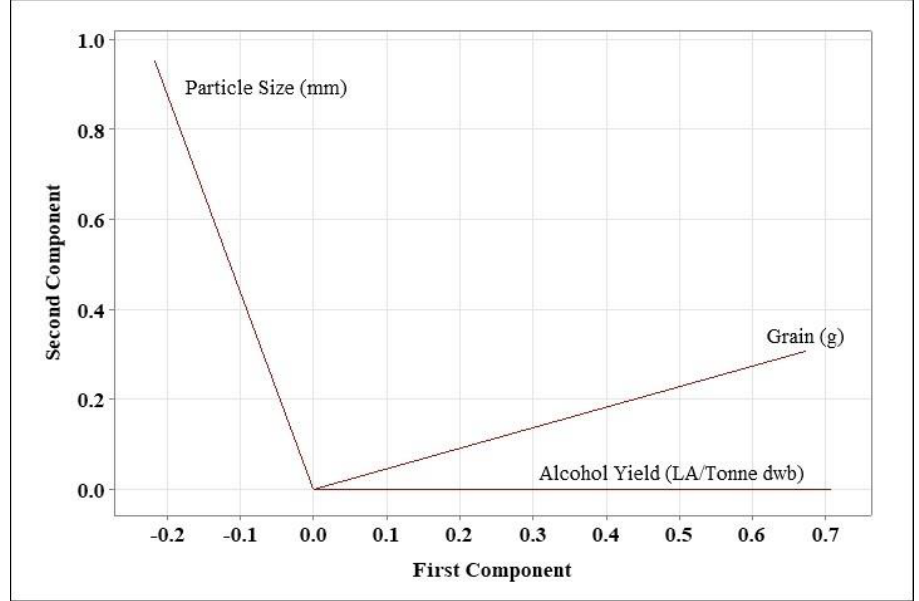
Figure 4. Principal component analysis of the dependent (alcohol yield) and independent variables (grain amount and particle size) used in this study. The amount of grain used has the biggest impact on AY, due to the closeness of the lines for alcohol yield and grain amount.